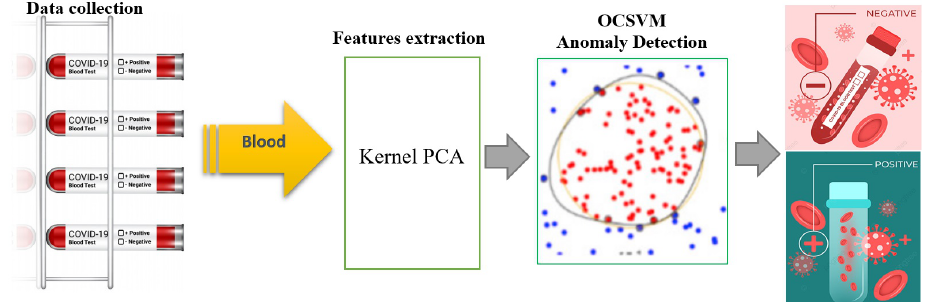
Figure 1. Flowchart of the proposed KPCA-OCSVM anomaly detection